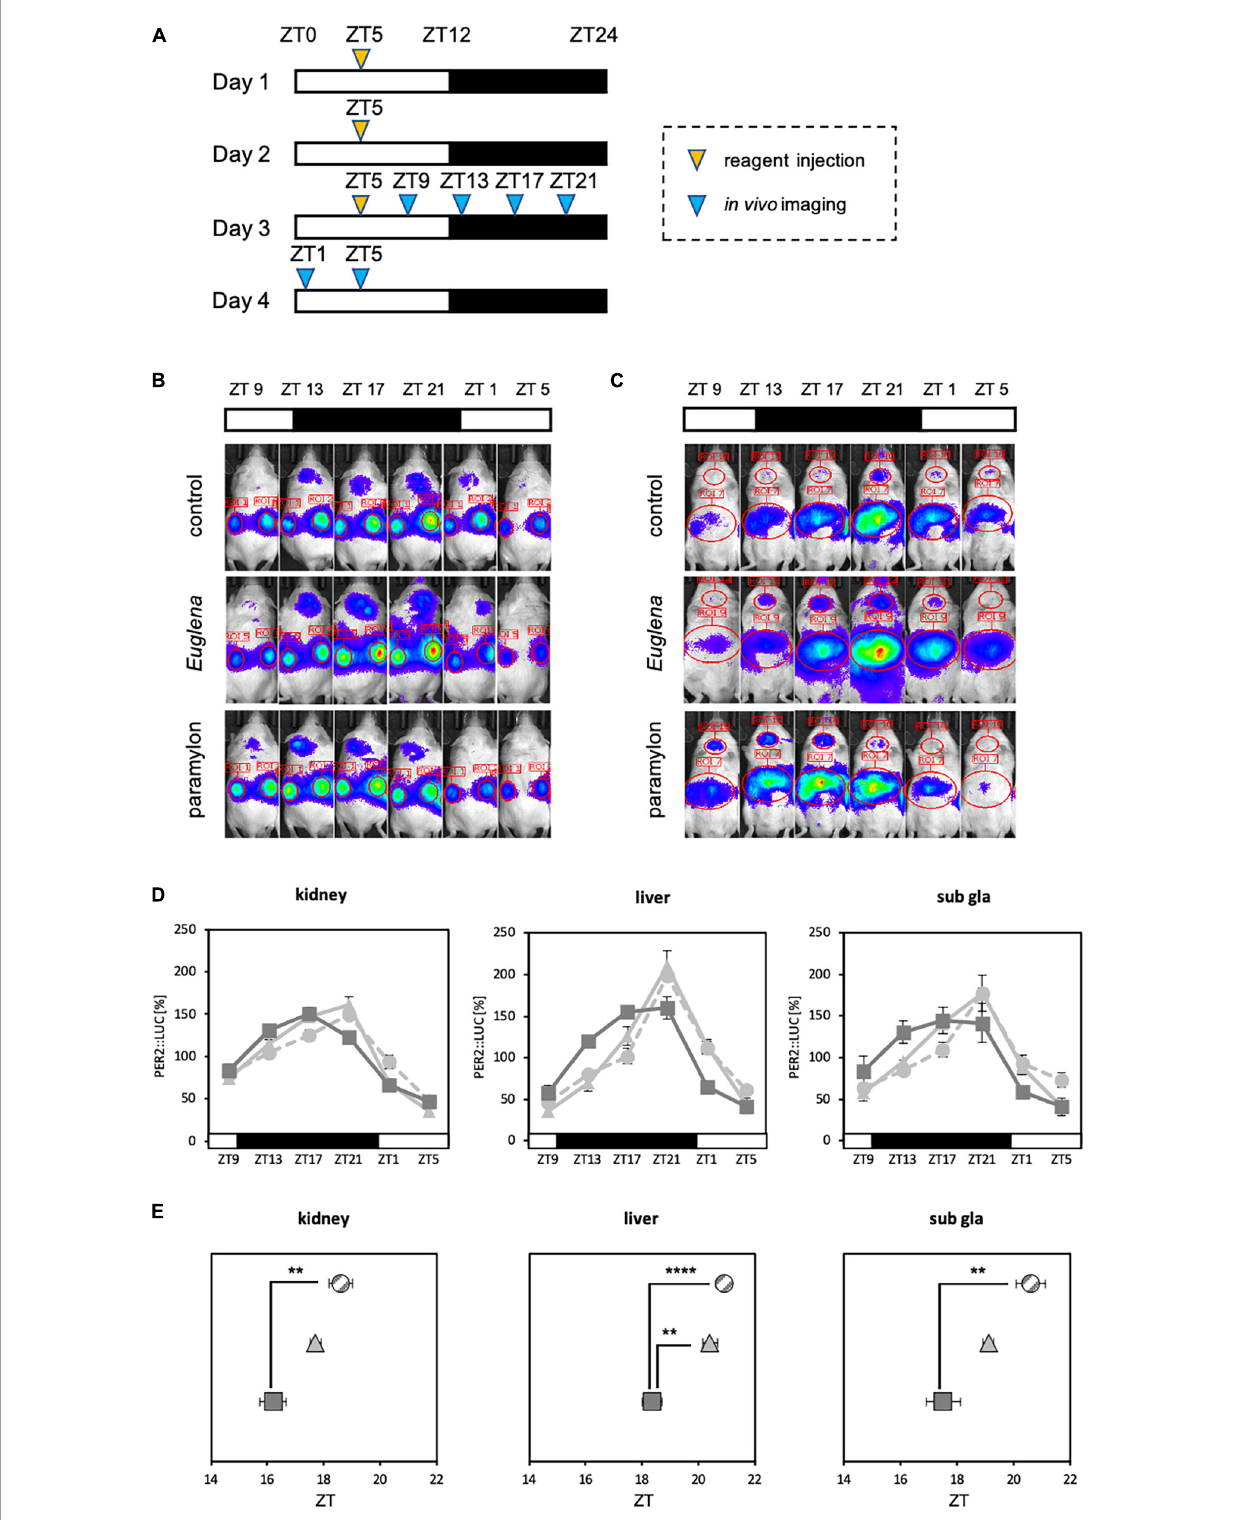
FIGURE4 Paramylon intake advances the phase of peripheral clocks. (A) Experimental schedule. The yellow arrowhead indicates the reagent administration time, and the blue arrowheads indicate the timings of in vivo bioluminescence imaging. (B,C) Representative images of in vivo bioluminescence imaging. (B) The luminescence observed in the kidney. (C) The luminescence observed in the liver and submandibular gland. (D) Waveforms of PER2:LUC rhythm in each tissue. Light gray dotted lines indicate the control group, light gray lines indicate the Euglena group, and dark gray lines indicate the paramylon group. (E) Peak phases of PER2:LUC rhythm in each tissue. Gray striped dots indicate the control group, light gray dots indicate the Euglena group, and dark gray dots indicate the paramylon group. Values are expressed as mean ± SEM. (control and paramylon group: n = 8, Euglena group: n = 4). ** p < 0.01, **** p < 0.0001 (one-way ANOVA with Tukey’s multiple comparisons